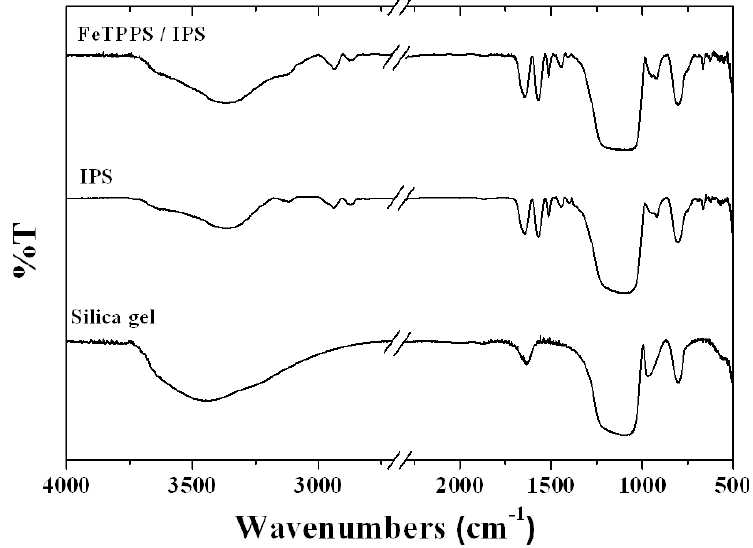
Figure 1. FT-IR spectra of silica gel, IPS and FeTPPS / IPS with KBr